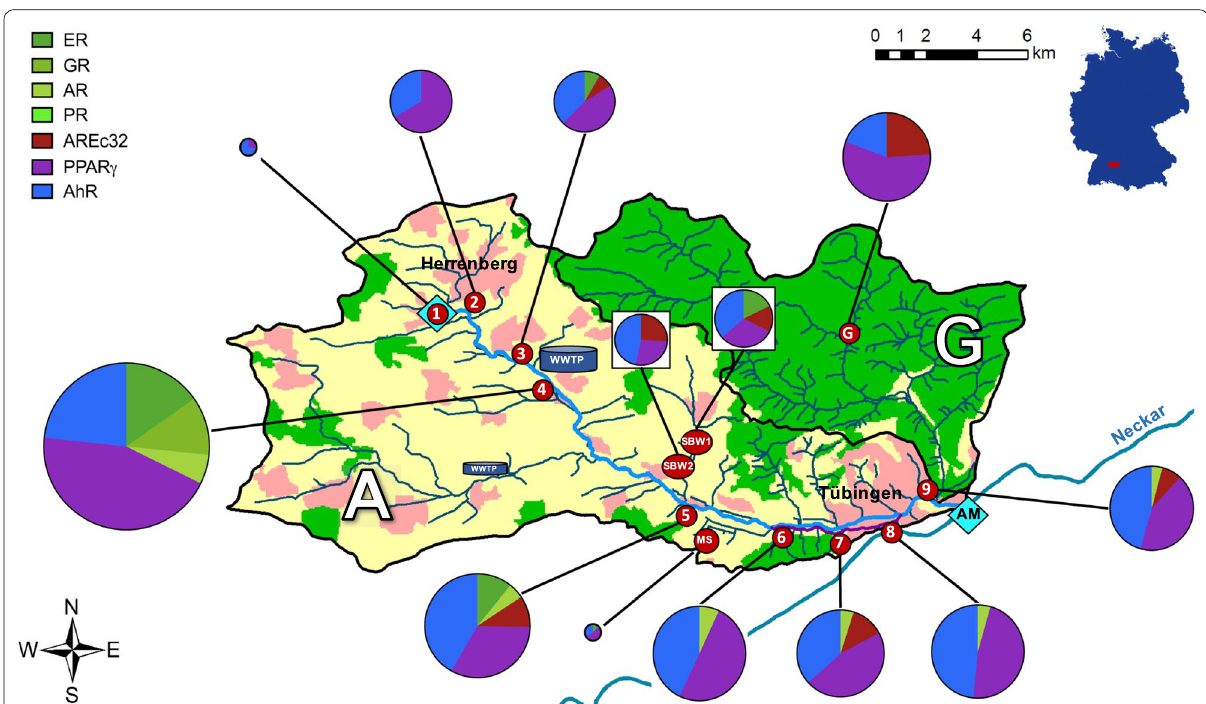
Fig. 1 Catchments of the river Ammer (A) and its tributary Goldersbach (G). From source (cyan diamond at sampling site 1) to mouth (AM, cyan diamond downstream of sampling site 9), the Ammer River flows over 22 km; numbers in red circles indicate sampling sites (Table 1). Downstream of site 6 the Ammer bifurcates, only the Canal (purple line) was sampled. Before site 9, the canal and the stream merge again. The pie charts present the bioassay results at each sampling site and show the toxicological patterns (chart colors) and average cytotoxicity (chart size). The colors within the map illustrate urban areas (pale red), agricultural areas (yellow) and woodland